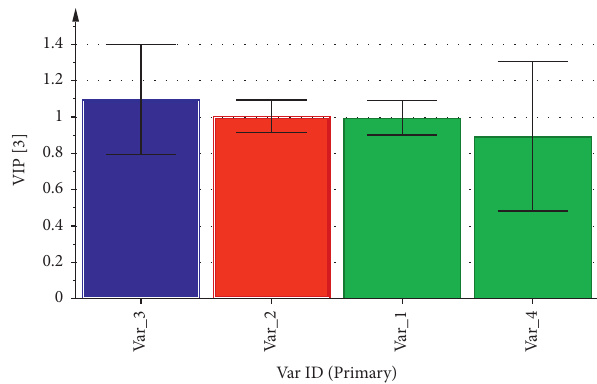
Figure 7: VIP values of four common peaks in 33 batches of S. divaricata